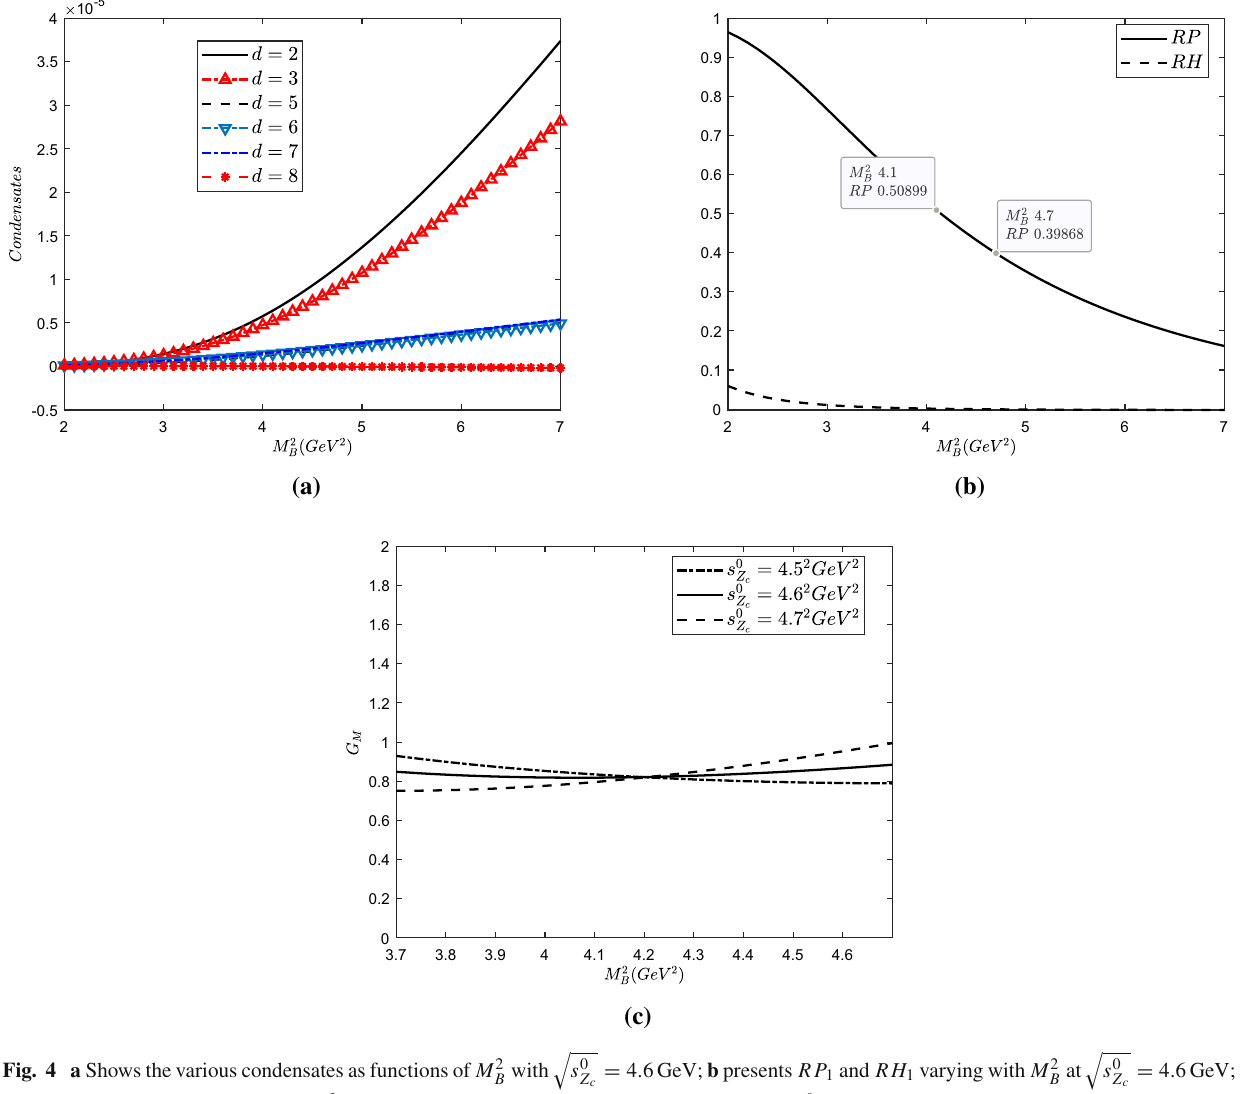
Quark configuration Method Value Axialvector tetraquark Light-cone sum rule 0 . 67 ± 0 . 32 μ N [26] Axialvector tetraquark QCD sum rule 0 . 47 + 0 . 27 − Axialvector molecule QCD sum rule 0 . 19 + 0 . 04 −